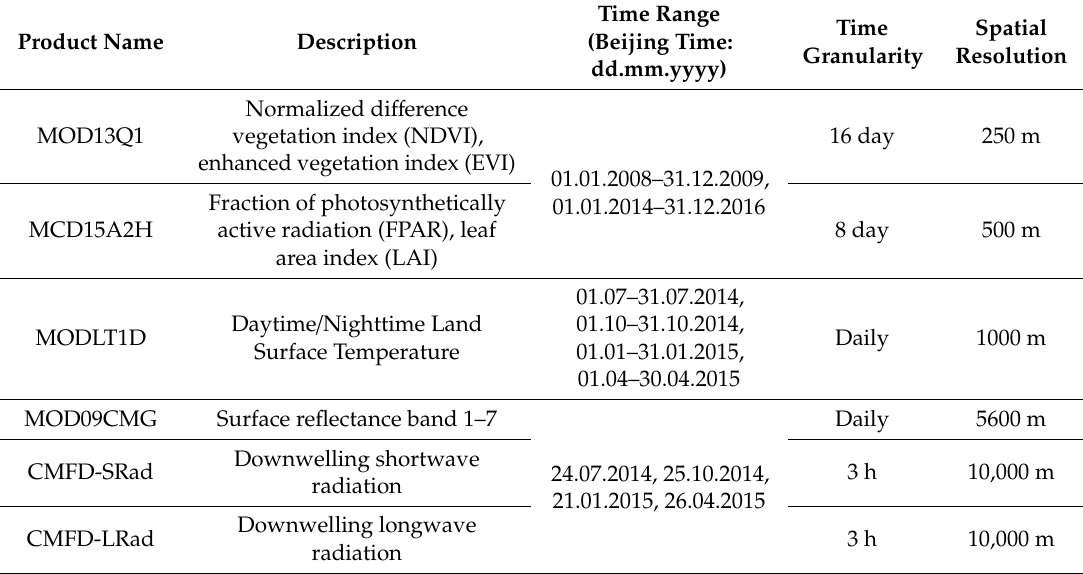
Table 2. Specifications of Moderate Resolution Imaging Spectroradiometer (MODIS) products used in the